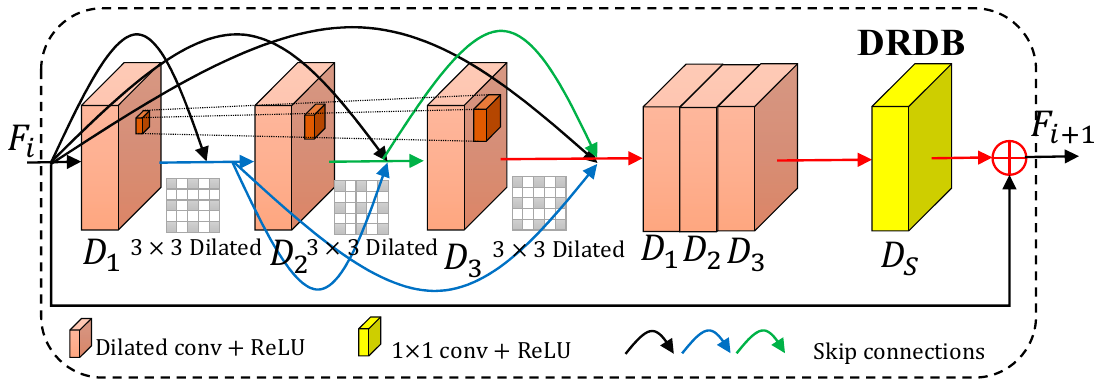
Figure 3. Implementation of the dilated residual dense block (DRDB).